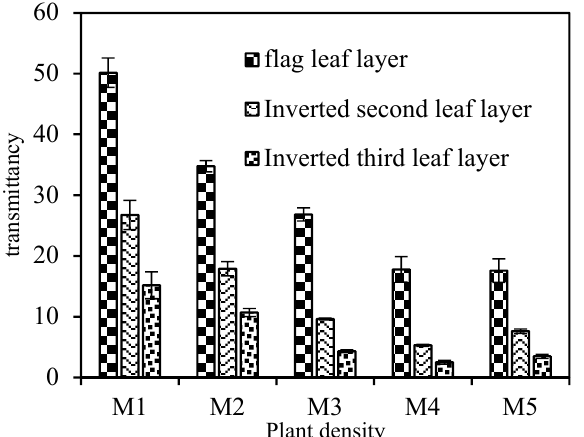
Figure 2. Effects of plant density on canopy transmittance. M1, 75 × 10 4 /hm 2 ; M2, 150 × 10 4 /hm 2 ; M3, 225 × 10 4 /hm 2 ; M4, 300 × 10 4 /hm 2 ; M5, 375 × 10 4 /hm 2 . Vertical bars represent ± SE of the mean.